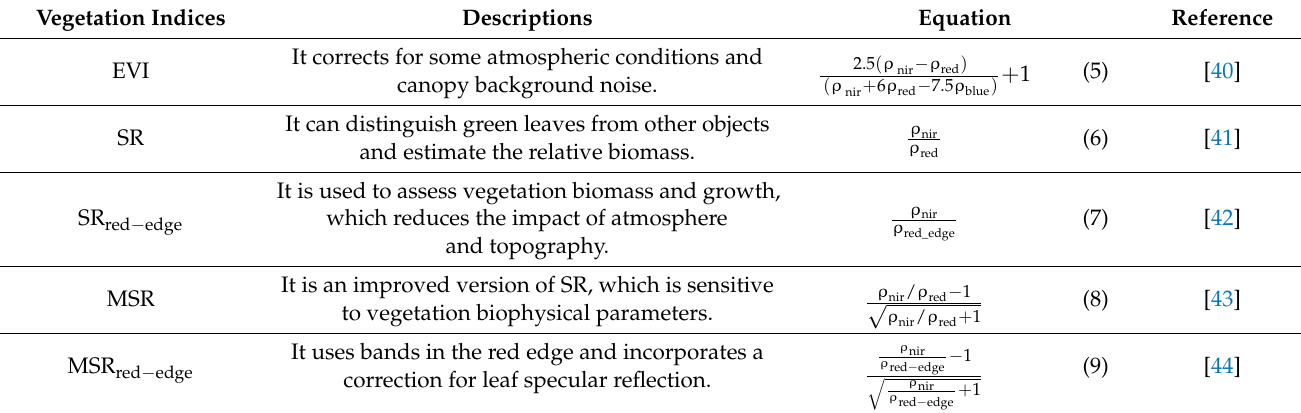
Table 4. Vegetation indices selected for the difference analysis. ρ nir is the near-infrared band; ρ red is the red band; ρ red_edge is the red-edge